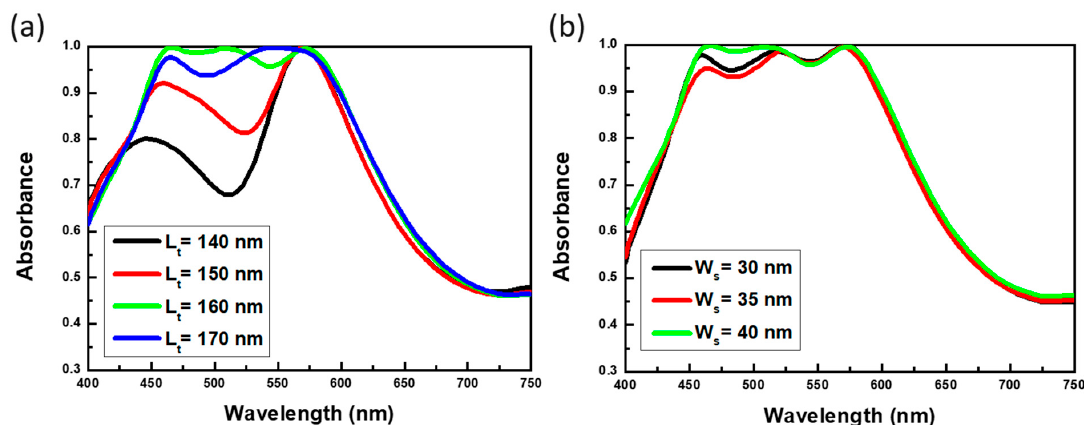
Figure 4. Contributions of varying the ( a ) strip lengths and ( b ) strip widths to the absorptance spectra.